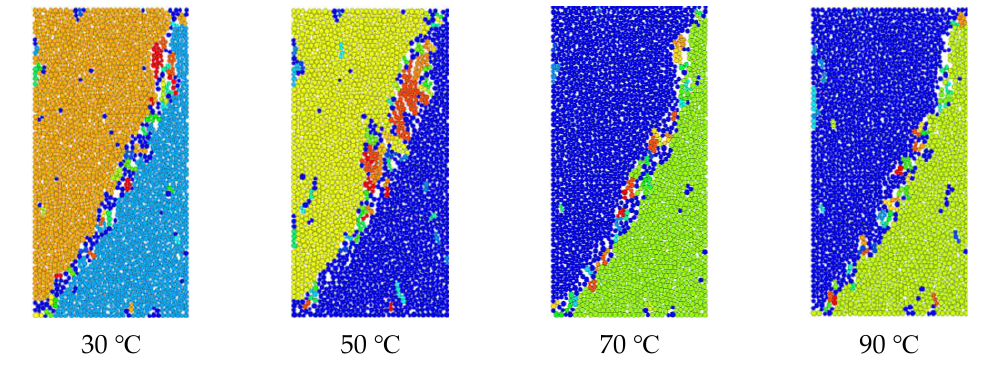
Figure 11. Destruction of the fragment. With the increase in temperature, the overall input energy decreased, the axial strain corresponding to the increase in dissipative energy advanced, and the peak elastic poten- tial energy decreased. However, the peak strength of elastic potential energy at 50 ℃ was